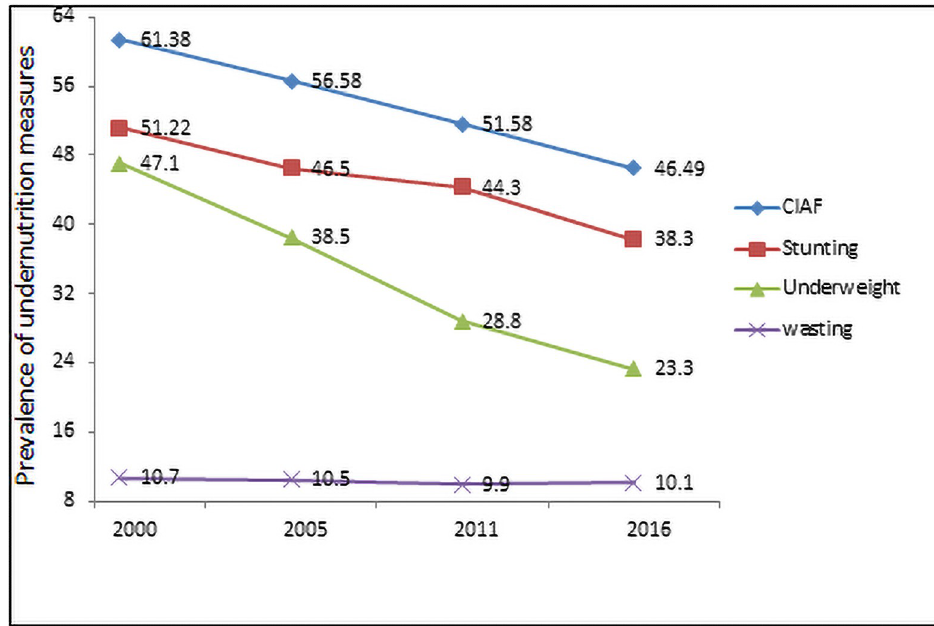
Fig 2. Distribution of under-nutrition prevalence status among U5C in Ethiopia in four consecutive survey years.